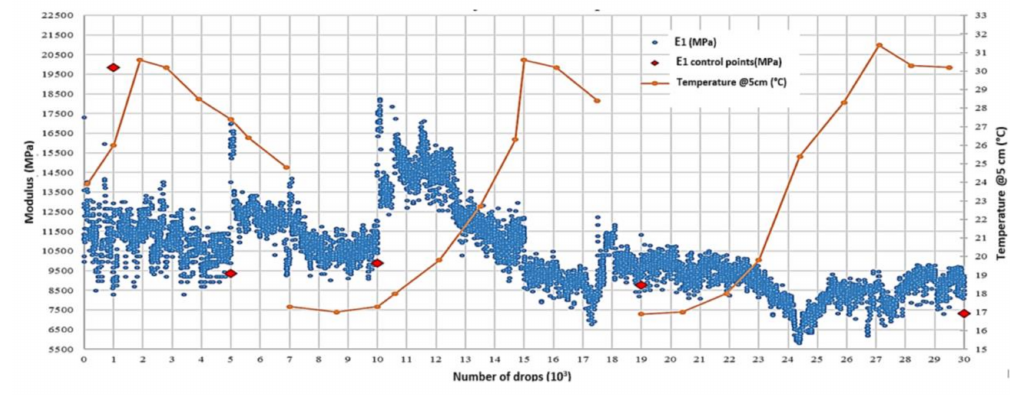
Figure 5. RTM modulus and temperature trends.